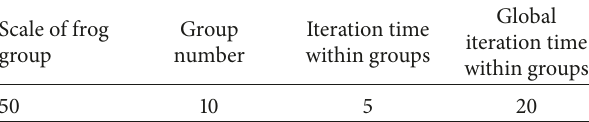
Table 4: Parameter selection of